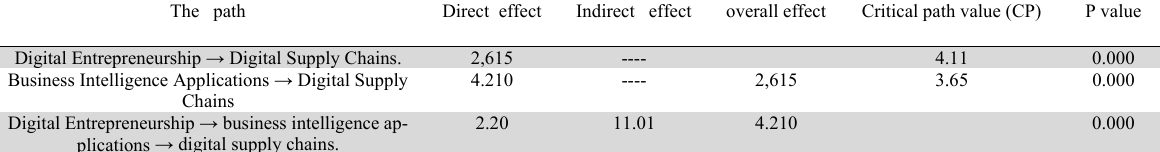
The results of the path analysis test for the impact of digital Entrepreneurship on digital supply chains through business intelligence applications as an intermediate variable The